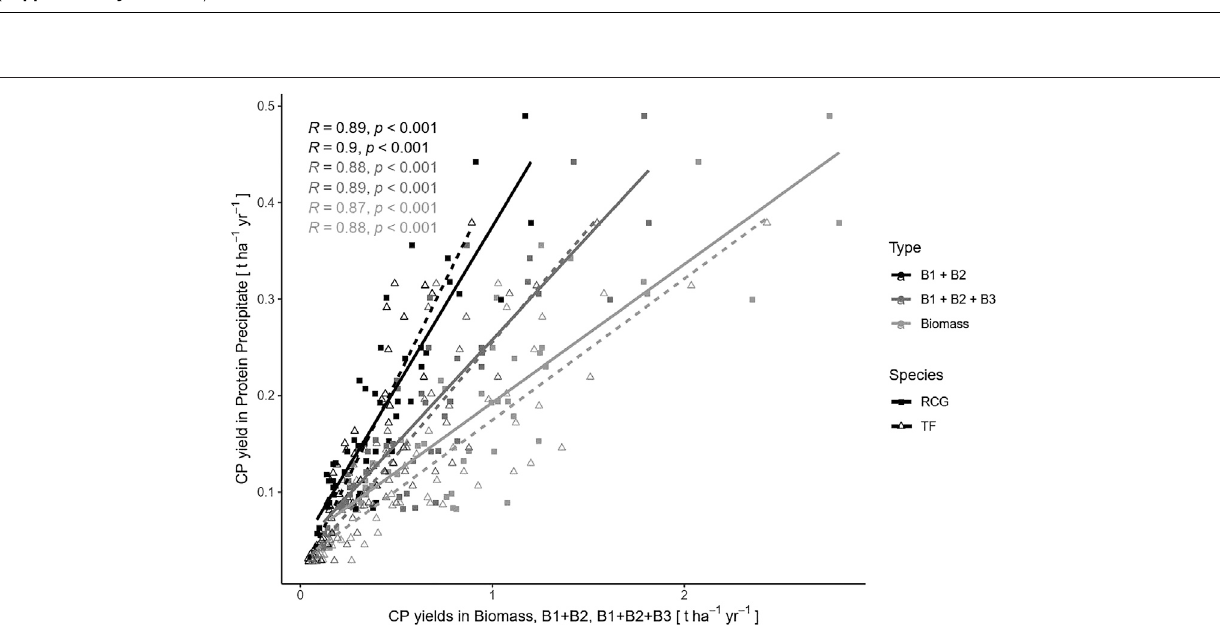
FIGURE 8 | Pearson correlations between yields of crude protein (CP) in precipitated protein and crude protein in biomass (light-grey lines), neutral soluble Cornell Net Carbohydrate and Protein System (CNCPS) fractions B1 + B2 (black lines), and the acid soluble CNCPS fractions B1 + B2 + B3 (grey lines) for the species reed canary grass (RCG, solid lines) and tall fescue (TF, dashed lines), across all treatments and harvest